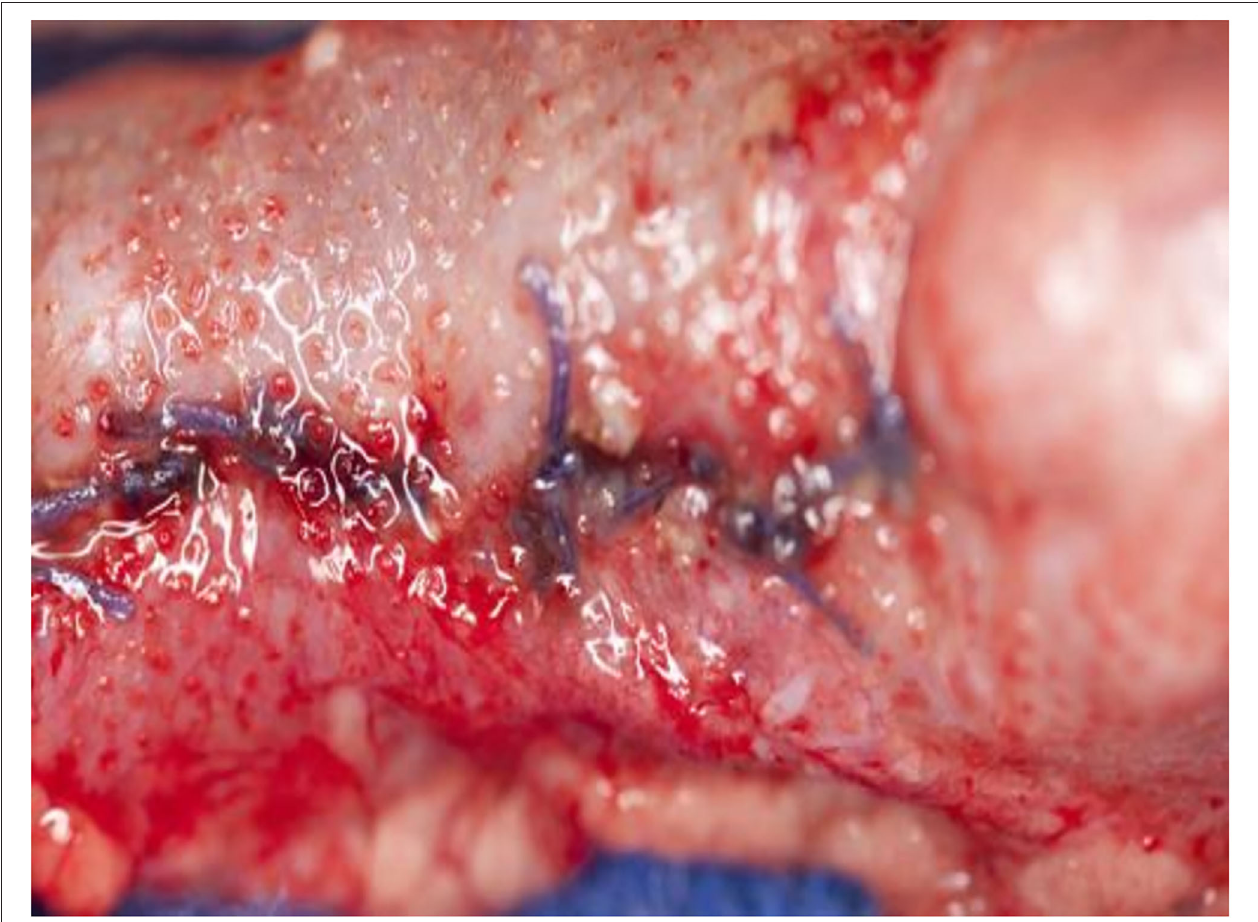
FIGURE 4 | Colon defect closed with single sutures after 8 hours of NP application.